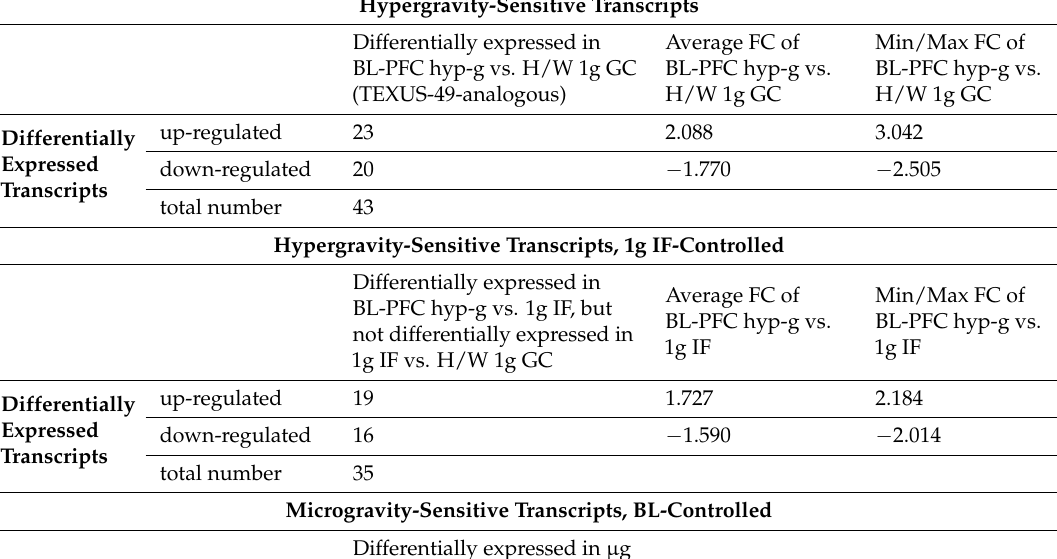
Table 3. Number of differentially expressed transcripts in comparisons of the experiment groups of the 19th DLR parabolic flight campaign. Differential expression is defined as t -test p -value < 0.05; fold change (FC) ≤ − 1.3 or ≥ +1.3. If the ratio is <1, FC is calculated as the negative reciprocal of the ratio. The term “transcripts” refers to 188 oxidative stress-related transcripts, representing 86 genes. For the abbreviations of the experiment group names see Table 1.